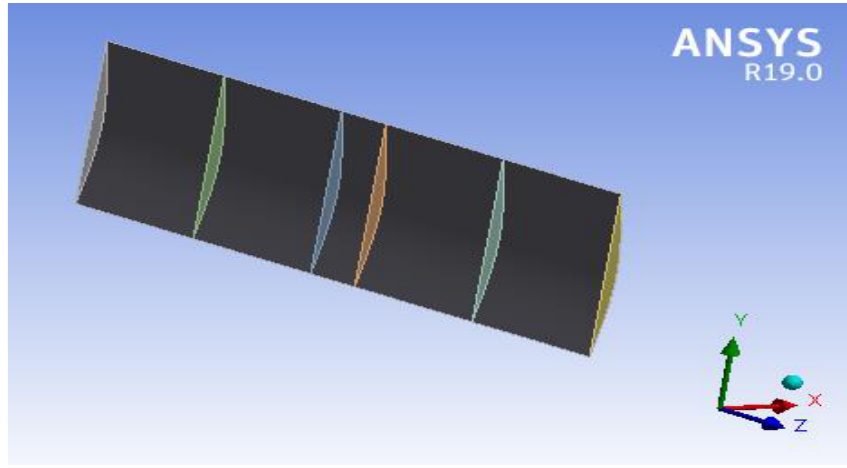
Figure 17. Internal stiffeners arrangement.